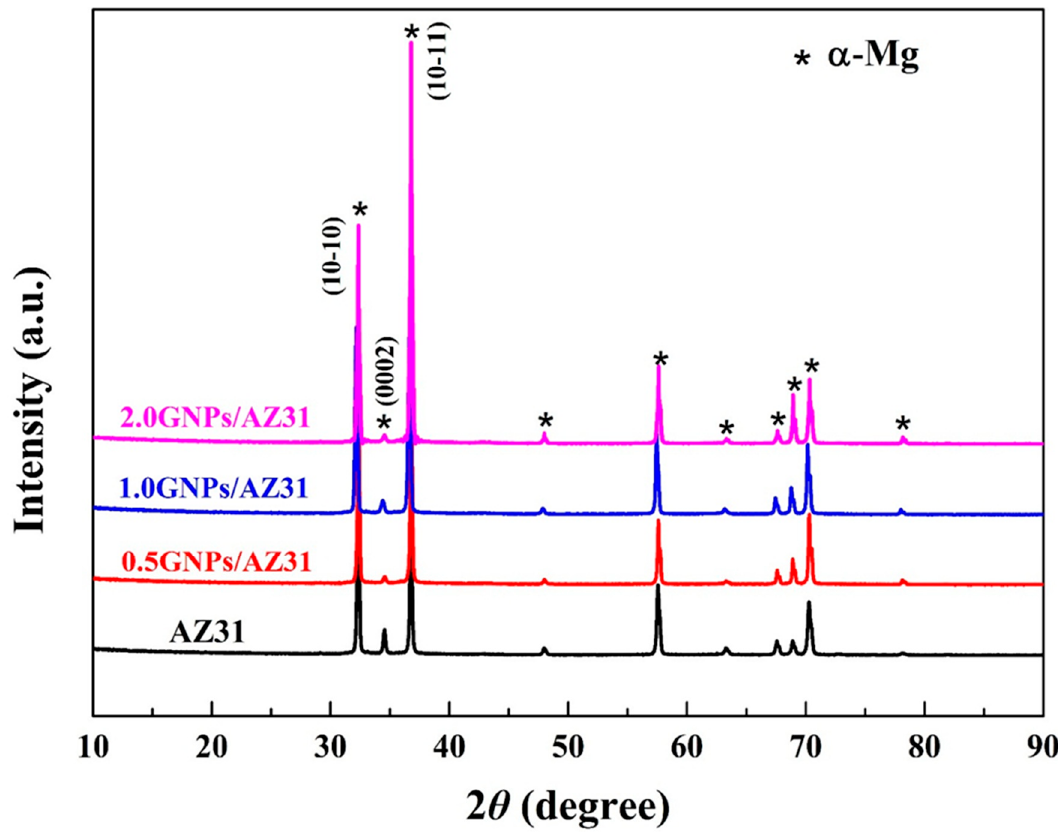
Figure 2. XRD pattern of the unreinforced AZ31 alloy and the GNPs / AZ31 composites. Table 3. Texture results of AZ31 alloy and the GNPs / AZ31 composites based on XRD. Samples